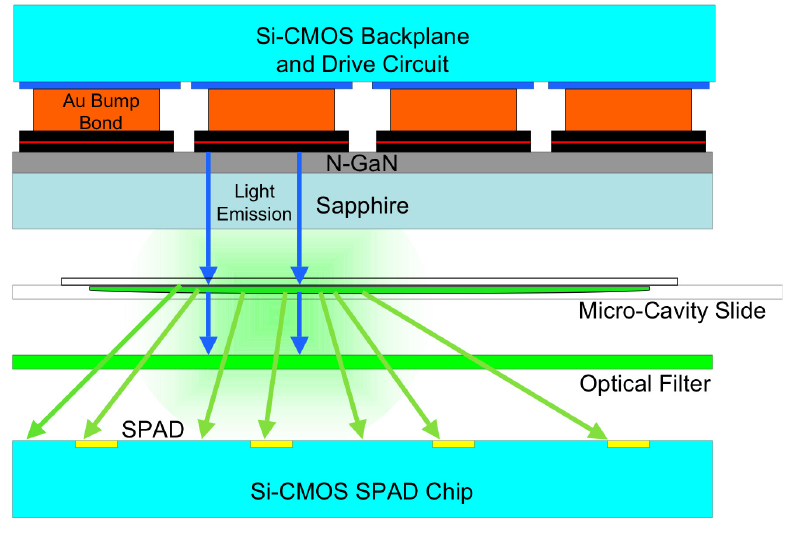
Figure 2. Cross-section of the two-chip